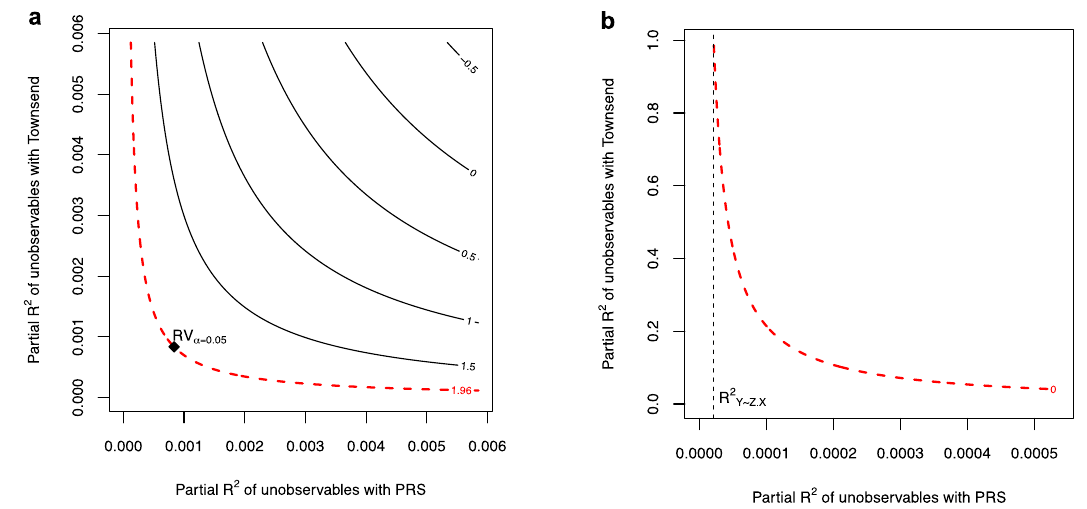
Fig. 5 Visual depiction of the sensitivity statistics RV α and R 2 YZ in the sensitivity contours for Townsend deprivation index. a Sensitivity contour j X showing the robustness value at the 5% signi fi cance level, RV α = 0.05 . b Sensitivity contour showing the partial R 2 of the genetic instrument with the outcome, R 2 YZ j X